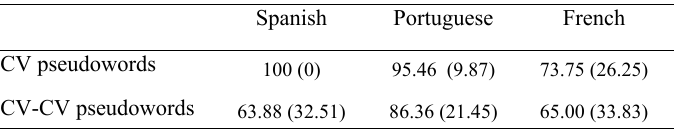
Table VI: Mean percentages of correct responses for pseudoword spelling in Spanish, Portuguese and French at TP2 (February-March). Standard deviations in parentheses.